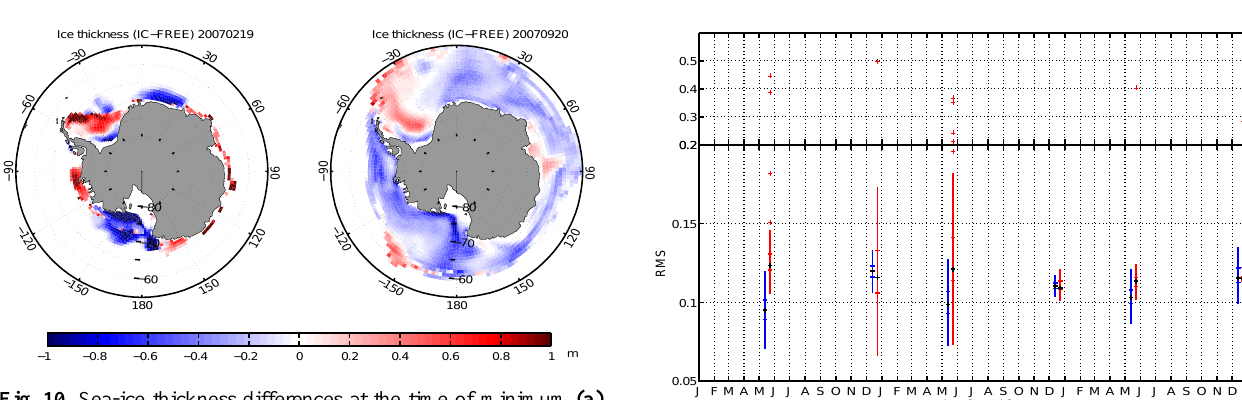
Fig. 10. Sea-ice thickness differences at the time of minimum (a) and the maximum (b) in 2007. Colors show the sea-ice thickness differences between FREE and IC. Fig. 11. Boxplot showing the RMS of the innovation covariance ma-